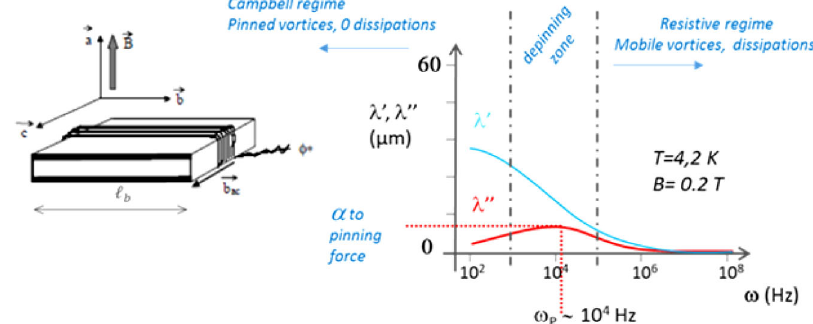
FIG. 3. Left: Principle of measuring ac complex penetration depth. The sample is immersed in a dc field B perpendicular to the sample surface ( == ⃗ a ). An additional ac field is applied to the sample via the coil around the sample. In this configuration currents are mainly R ⃗ ¼ l b , ⃗ c ) direction. The measured flux ϕ b dS ∼ 2 λ b 0 . At low frequency λ 0 ∼ δ confined in the ( ac ac ac b ≪ δ state). At high frequency λ 0 ∼ λ 00 ∼ λ . Right: Results obtained for high quality Nb monocrystal (modified from L rf